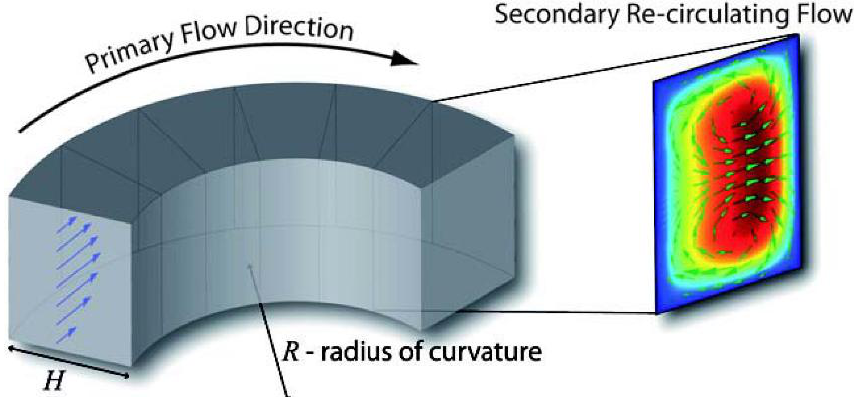
Figure 2. Secondary flow in cross-section. Ref. [40]. Copyright (2009), with permission from the Royal Society of Chemistry.